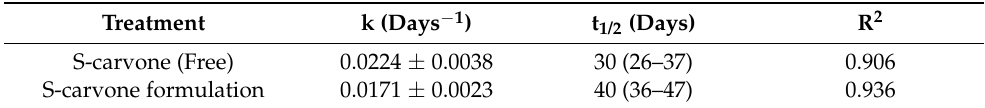
Figure 3. Dissipation curves for S-carvone applied to soil as free compound or supported on gran- ules of Cloisite ® 10A. Symbols denote experimental data points and lines are the dissipation curves fitted by the first-order kinetics. Error bars designate the standard errors of triplicates.